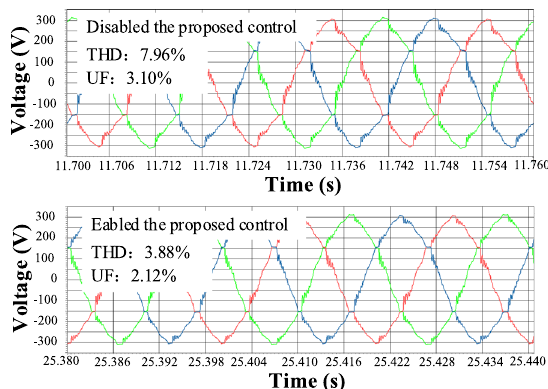
Fig. 24 The voltage waveform of the common